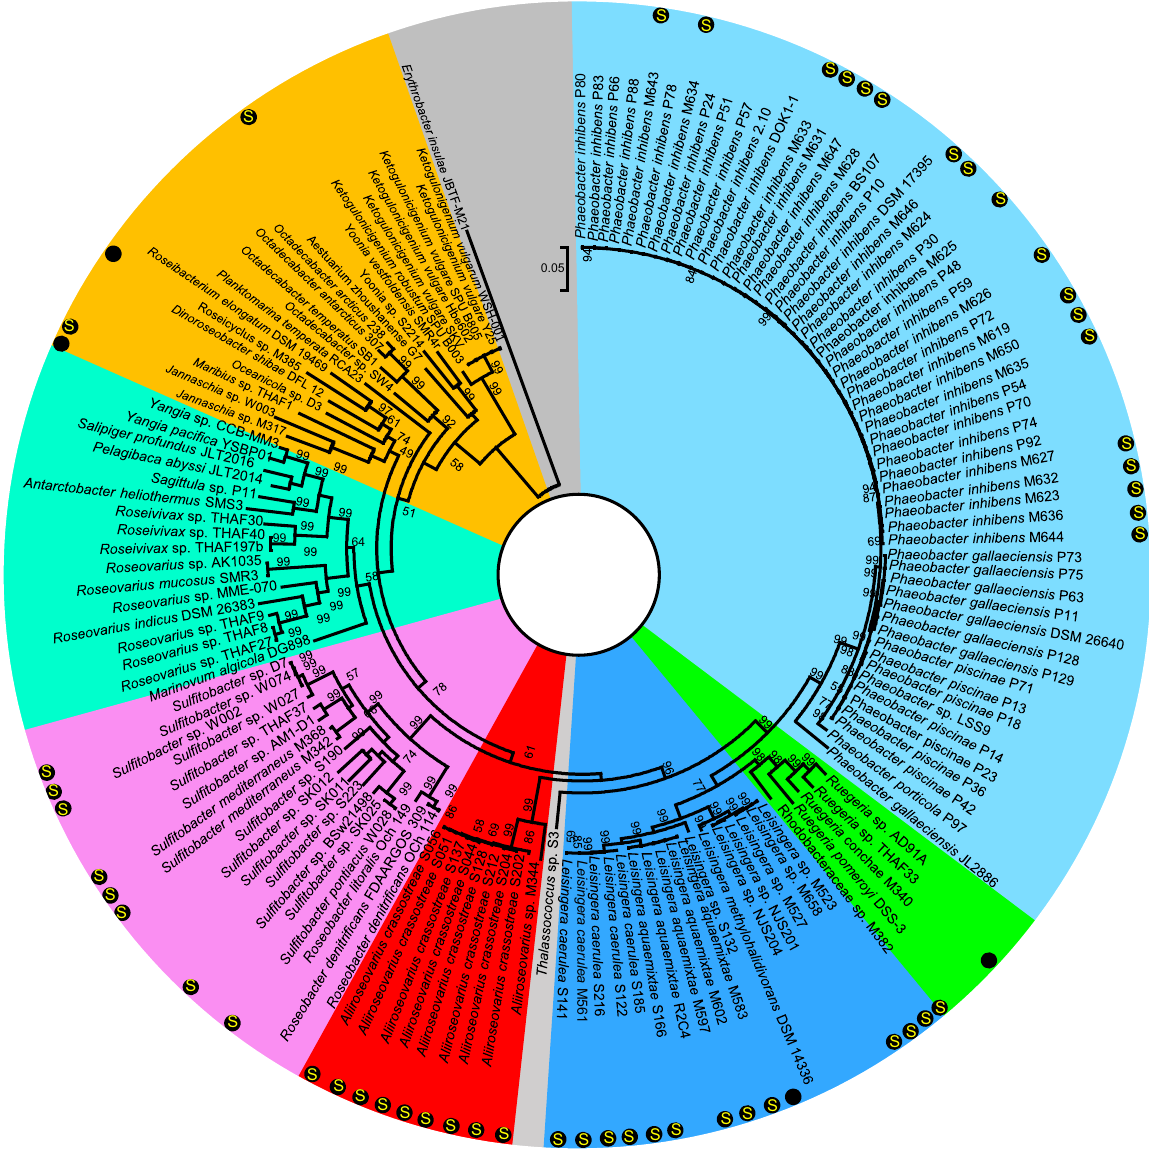
Fig. 1 | Phylogenetic tree of the 54 bio fi lm-derived strains and 95 reference Roseobacter strains with complete genomes in NCBI. Single-copy genes ( n =31) predictedfromthesegenomeswereconcatenatedtobuildthetree.Themaximum- likelihood method based on the Jones – Taylor – Thornton matrix-based model was